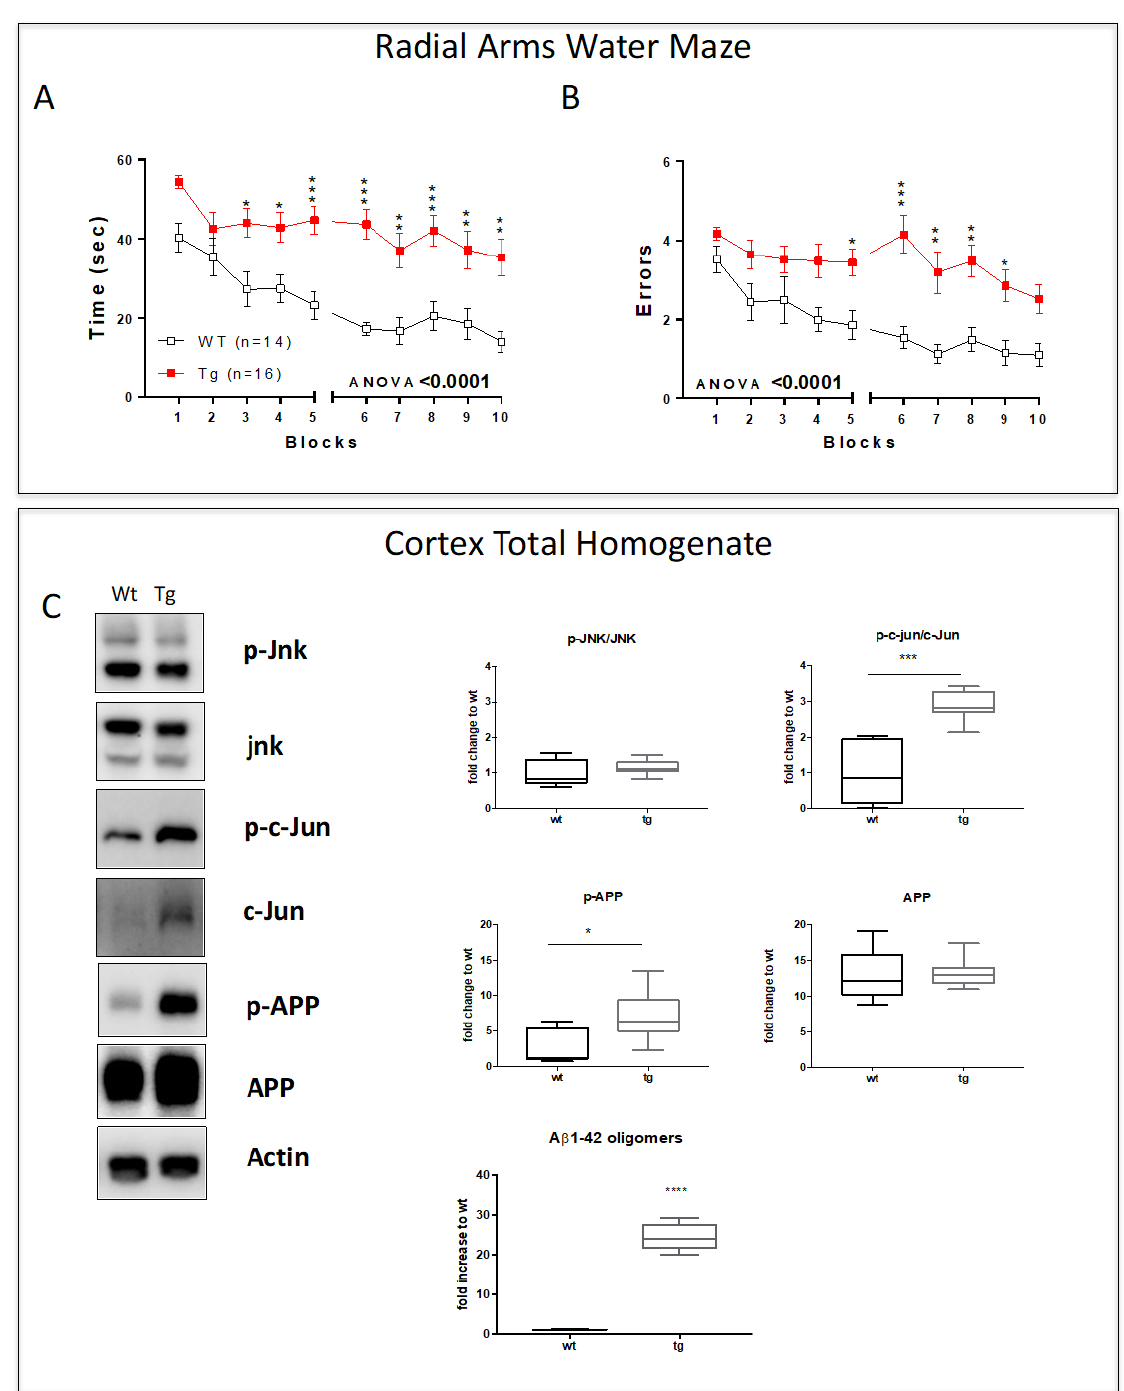
Figure 4. Cognitive impairment and parenchyma degeneration in the cortex of 10-month-old mice. ( A ) Time and ( B ) number of errors to find the submerged escape platform demonstrate the strong cognitive impairment in tg-5xFAD mice compared to wt. ( C ) Representative Western blots and relative quantifications of 10-month-old mice cortical total homogenate show a higher level of p-c-Jun/c-Jun ratio and P-APP in tg-5xFAD vs. wt mice and no changes in p-JNK/JNK and APP levels. Elisa A β 1-42 oligomers evaluation in the cortical total homogenate. Genotypes are compared using t -tests. Statistical significance: * p < 0.05, ** p < 0.01, *** p < 0.001, **** p < 0.0001. Data are expressed as mean ± SEM.